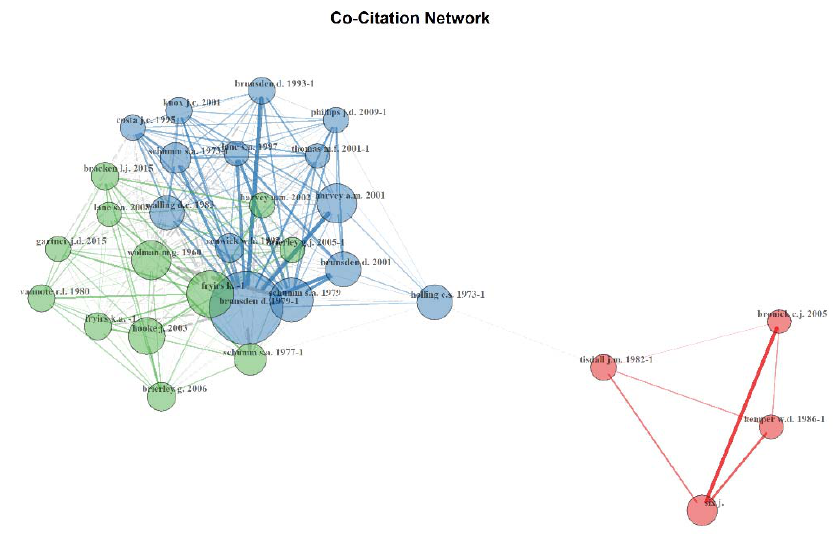
Figure 5. Co-Citation Network.